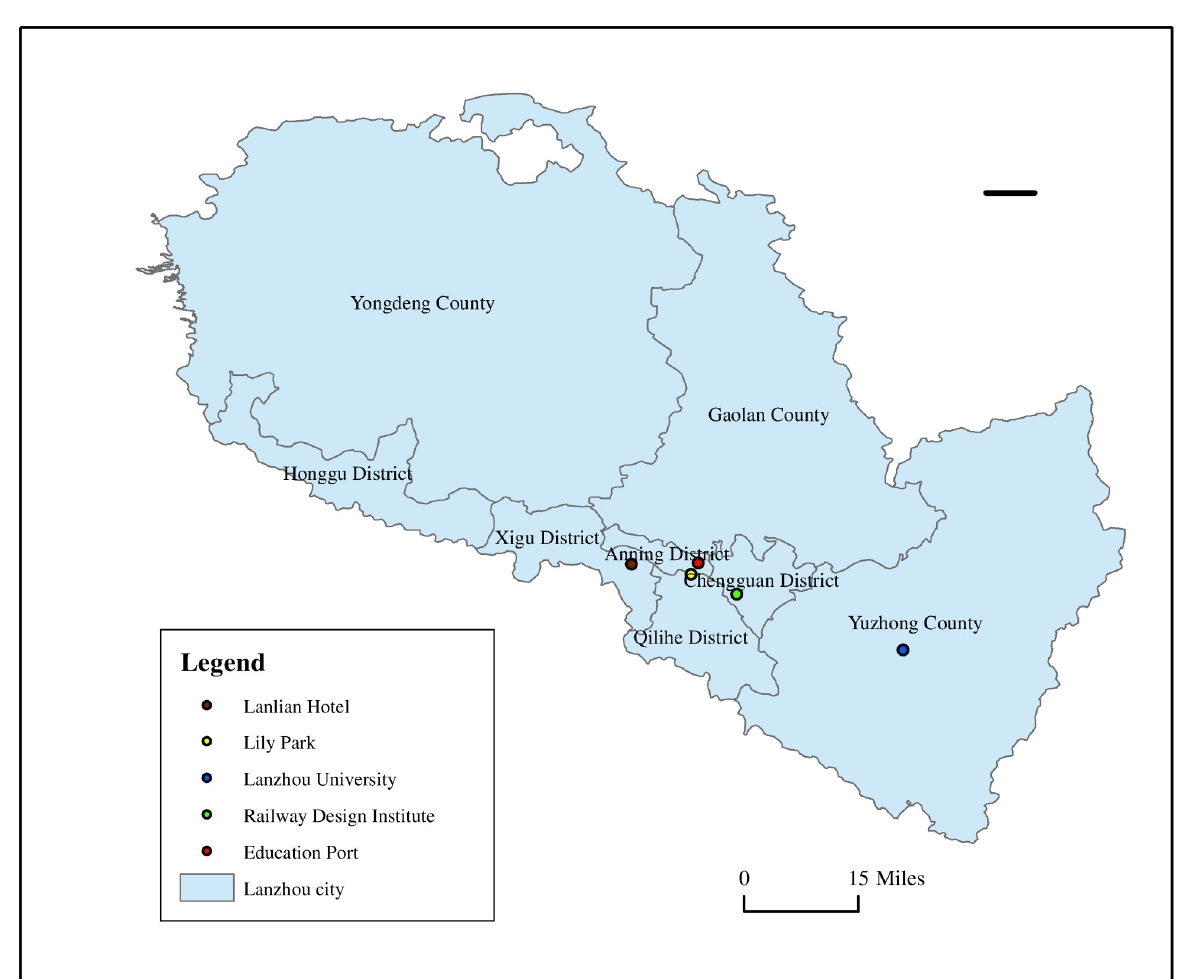
Fig 6. The locations of five selected typical districts in